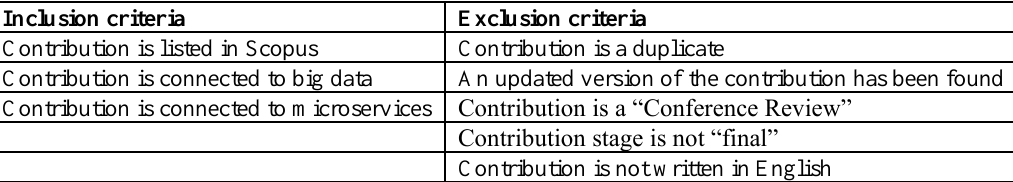
Table 3. Inclusion and exclusion criteria